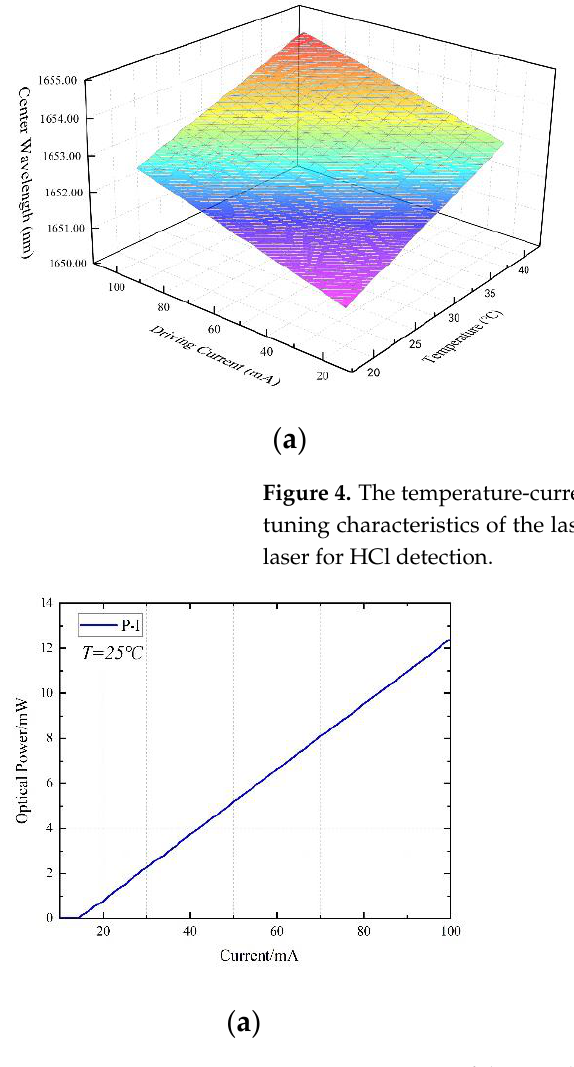
Figure 5. Variation of the DFB laser output power with driving current: ( a ) The P-I (power-current) curves of the laser for CH 4 detection.; ( b ) The P-I curves of the laser for HCl detection.